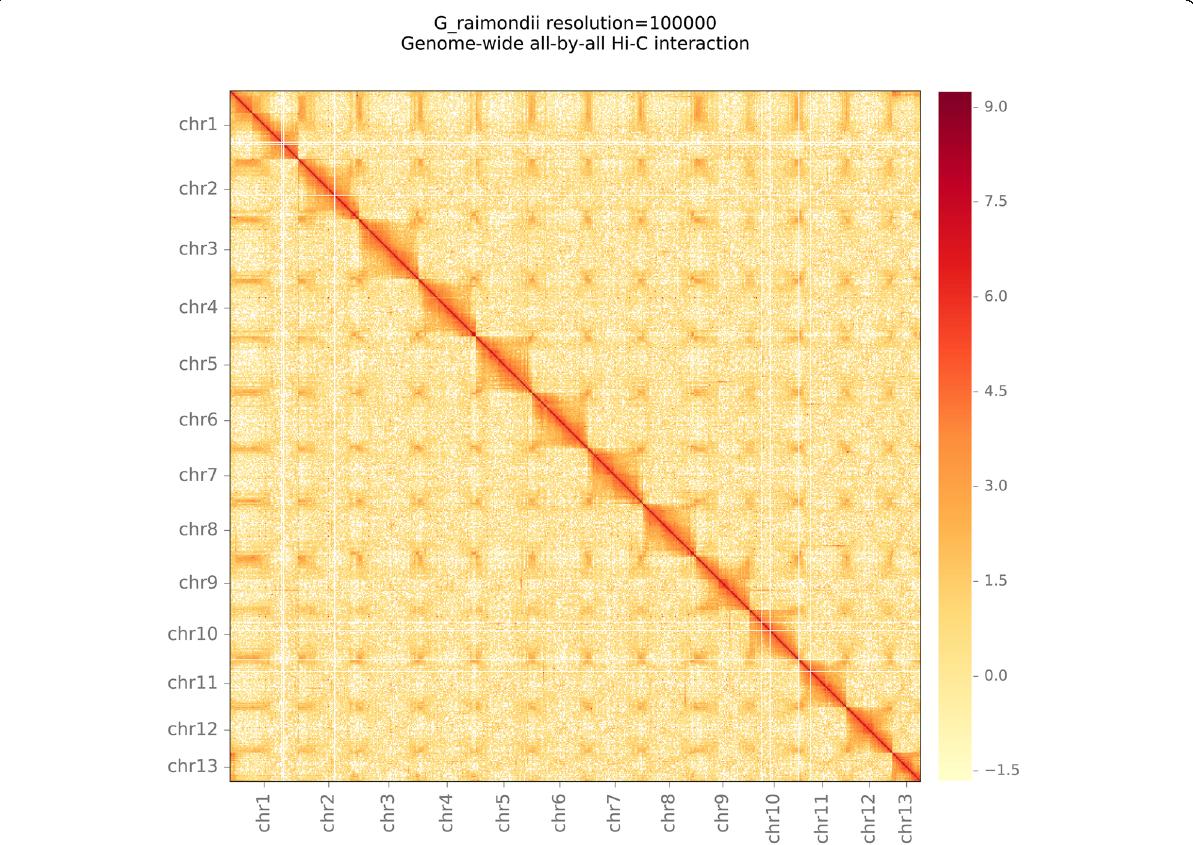
Fig. 1 The heat-map of the reassembled result at a 100-kb resolution. Hi-C interactions were detected in the reassembled G.raimondii genome sequences, and most interactions maps of chromosome sequences suggested that the genome sequence was assembled in the correct order. The darker red dot is representing the higher interaction between